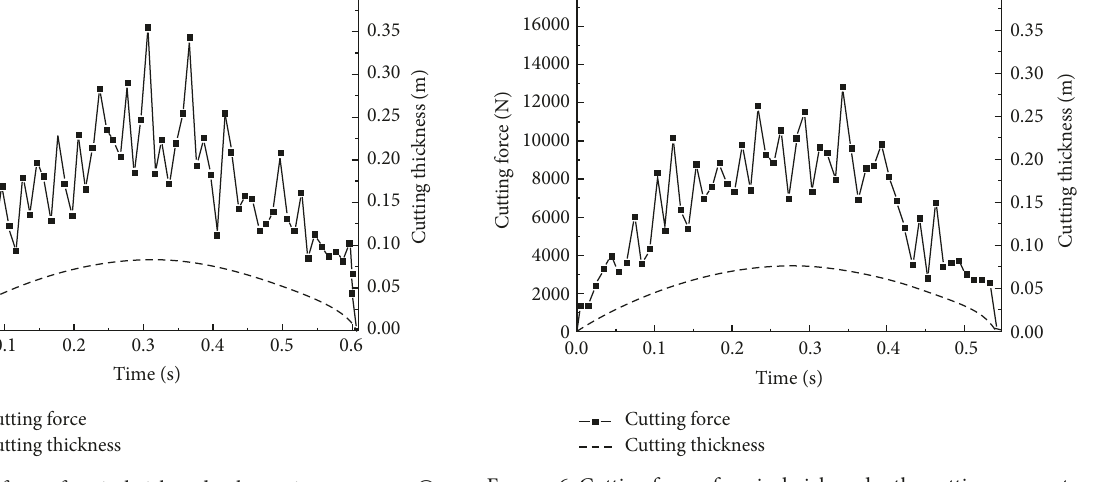
Figure 5: Cutting force of conical pick under the cutting parameter A . cutting state, particle velocity vector, and sectional of bonding diagrams when conical pick is at the beginning, middle, and end position of the cutting process. In the particle velocity vector diagrams, the direction of the arrows indicates the instantaneous velocity direction of the coal particles, and the color of the arrows represents the instantaneous velocity of particles, which increases gradually with blue, green, and red in turn. And in the section of bonding diagrams, the strip represents the bonding between the coal particles, which constitutes bond networks; the red and blue color represent large and little cohesive force, respectively.